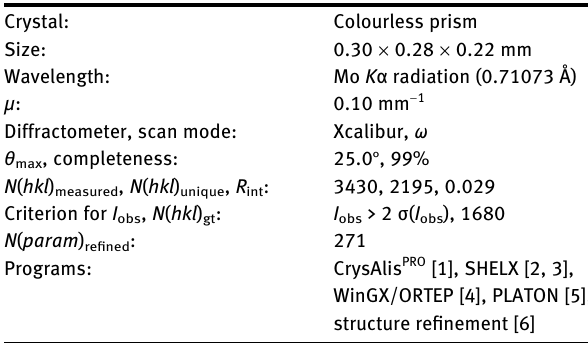
Figure 1: The molecular structure of the title compound. Displacement ellipsoids are drawn at the 50% probability Table  : Data collection and handling.